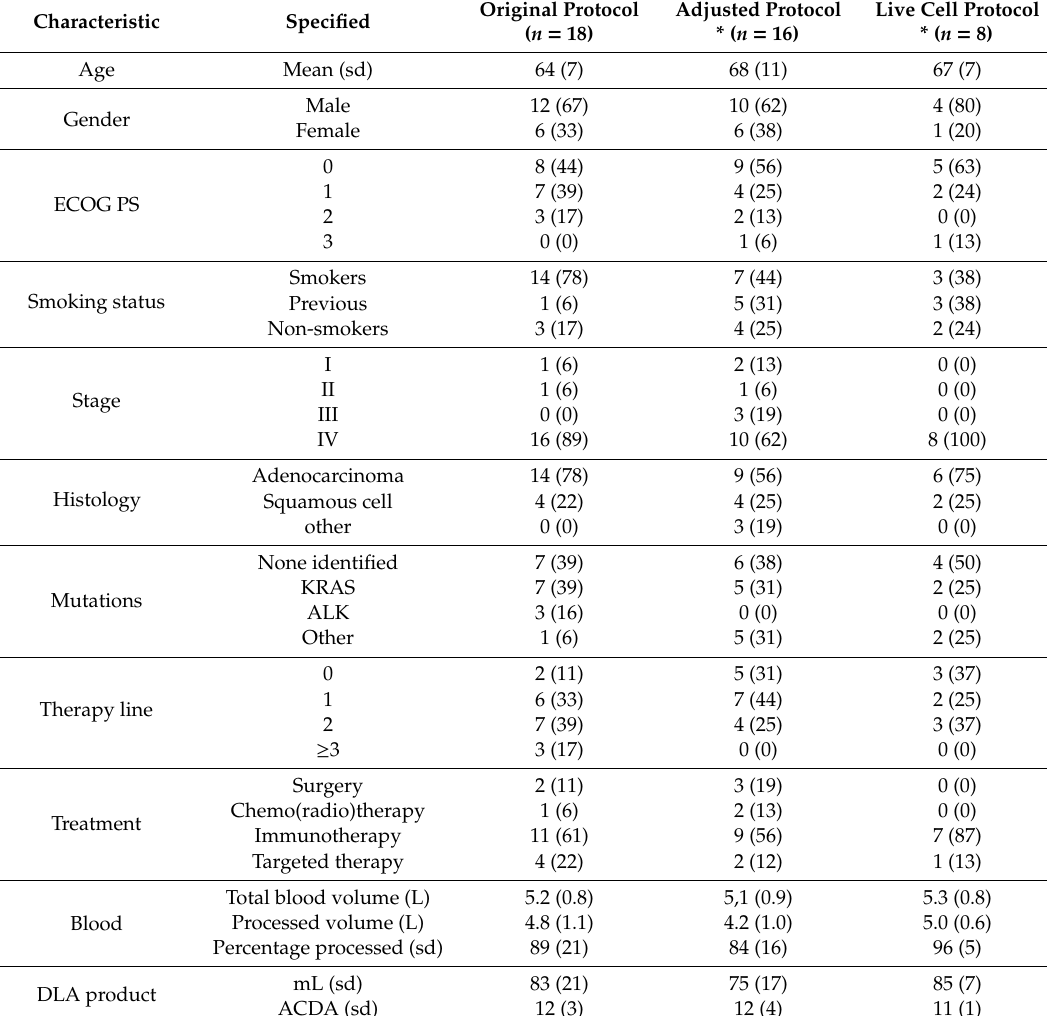
Table A2. Characteristics of non-small-cell lung cancer patients undergoing apheresis and ISET ®